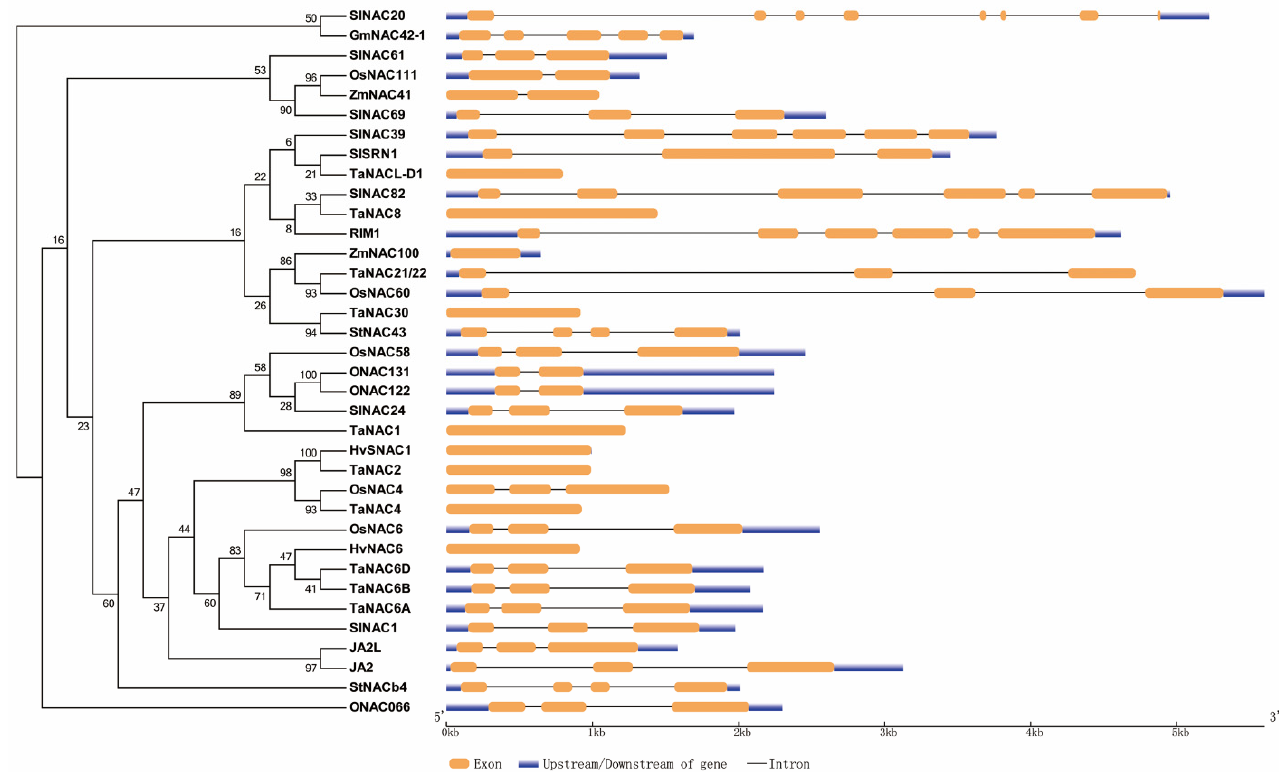
Figure 1. Phylogenetic and gene structure analysis of NAC TFs mentioned in this review. The left is phylogenetic analysis of some NAC TFs from rice, wheat, barley, maize, soybean, tomato and potato. The right is gene maps of the same NAC TFs, showing the numbers of exon and intron, the absence or presence of up- stream/downstream sequences and their relative length.